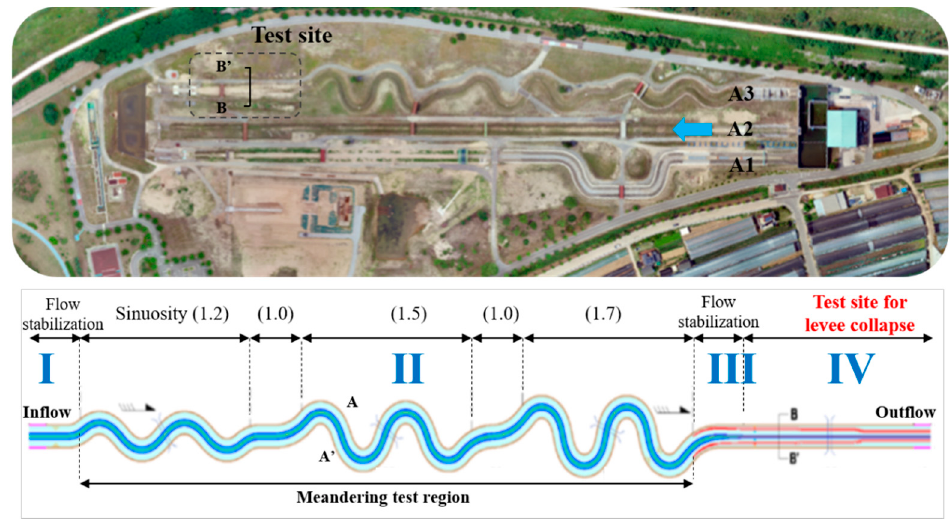
Figure 6. Testing site at the Andong River Experiment Center (REC).